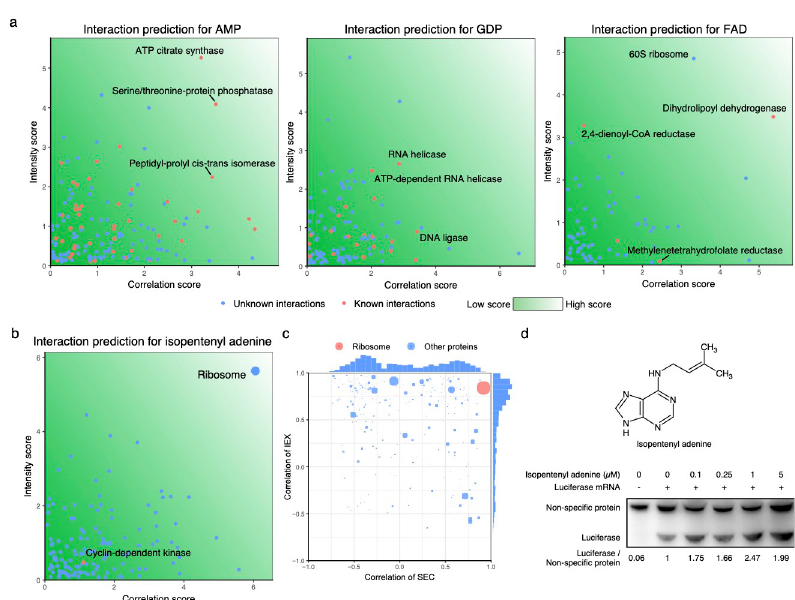
Fig 5. The predicted protein–metabolite interactions. (a) For three example proteins, predicted and known interactions with metabolites are shown. (b) The intensity score and correlation of all possible proteins which can interact with the metabolite isopentenyl adenine. Among all those proteins, the ribosome has the highest score. (c) Correlations between candidate proteins and isopentyl adenine are shown after independently performing IEX and SEC. Among all proteins, the ribosome has the highest score. (d) The experimental verification of the interactions between the ribosome and isopentenyl adenine: In the in vitro transcription system, luciferase was used as reported protein. Ribosome activity was measured by calculating the ratio of luciferase/non-specific